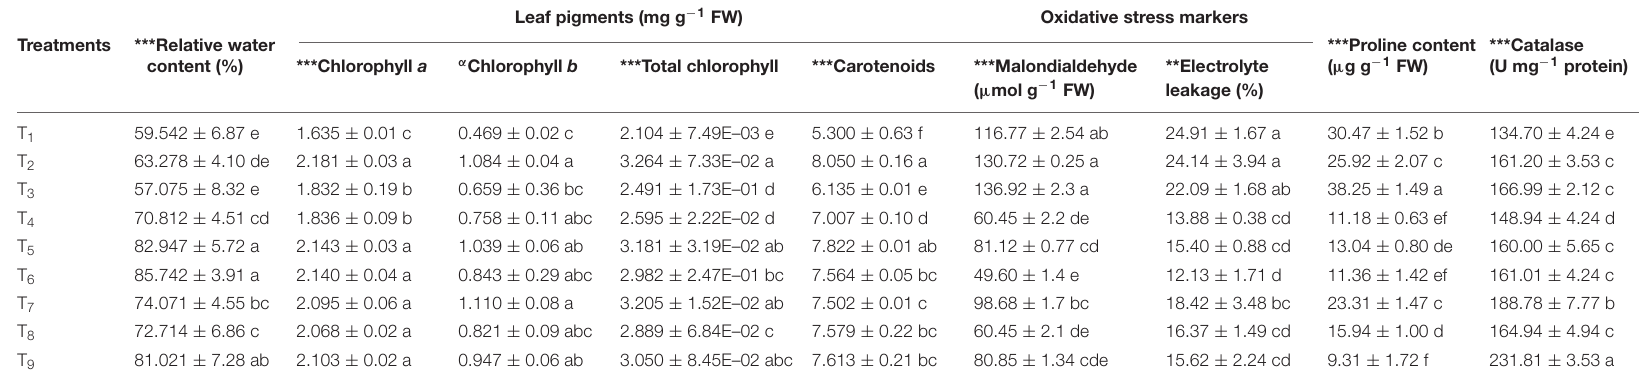
T 1 = Without bacterial inoculation, T 2 , T 3 , T 4 , T 5 , T 6 , T 7 , T 8 , and T 9 = Tomato plants inoculated with P. azotoformans ESR4, P. poae ESR6, P. gessardii ESR9, P. cedrina ESR12, P. chlororaphis ESR15, S. maltophilia ESR20, P. veronii ESR21, and B. aryabhattai ESB6, respectively. Data are means ± standard deviations. Different letters in column imply significant difference among treatments. ***, **, *, and α indicate significant difference at 0.1% (P ≤ 0.001), 1% (P ≤ 0.01), 5% (P ≤ 0.05), and 10% (P ≤ 0.1),